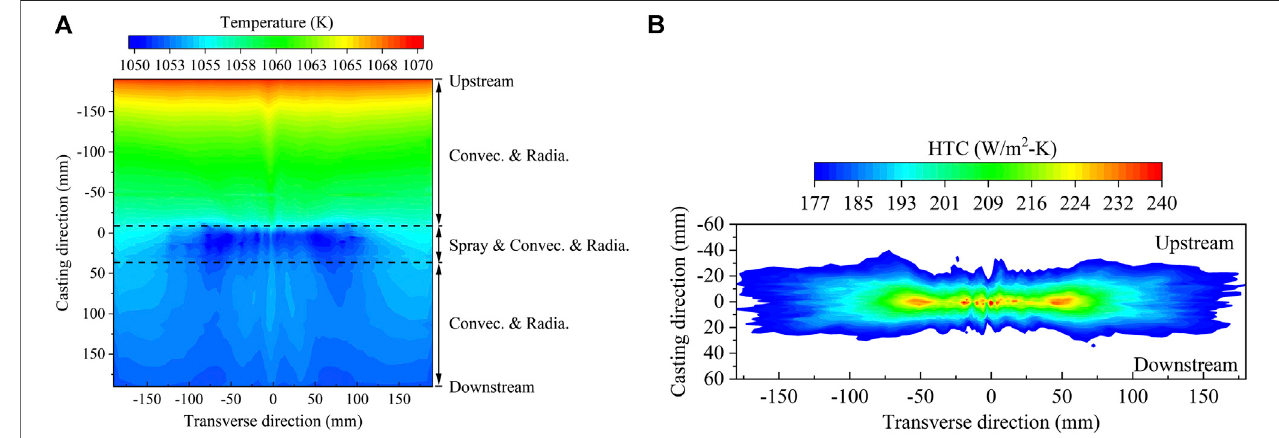
FIGURE 9 | (A) top view of slab surface temperature, and (B) top view of HTC pattern.